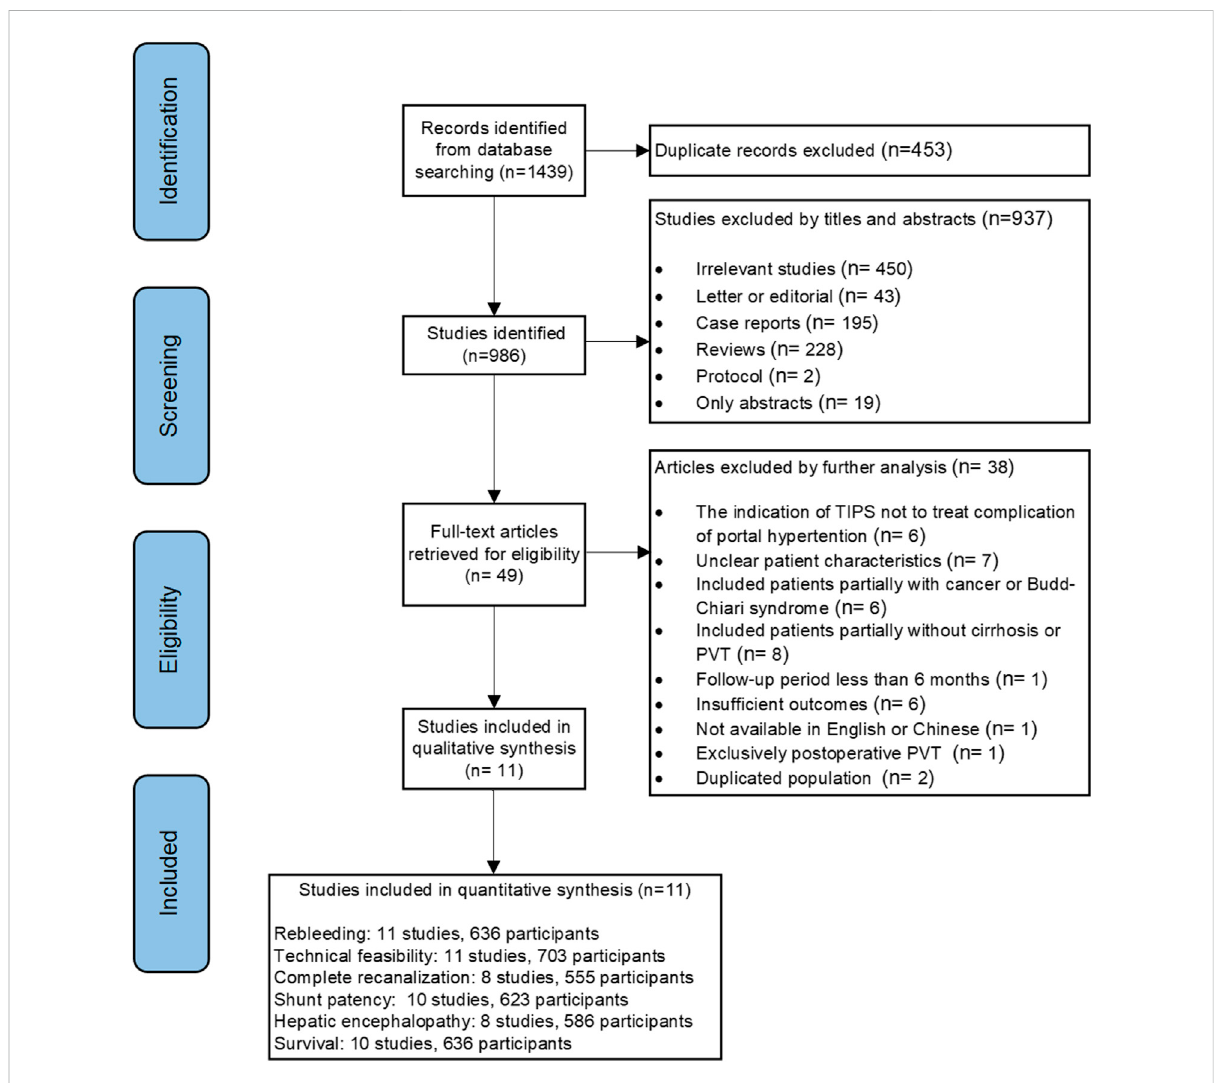
FIGURE 1 Flowchart showing the selection of studies for the present systematic review and meta-analysis.